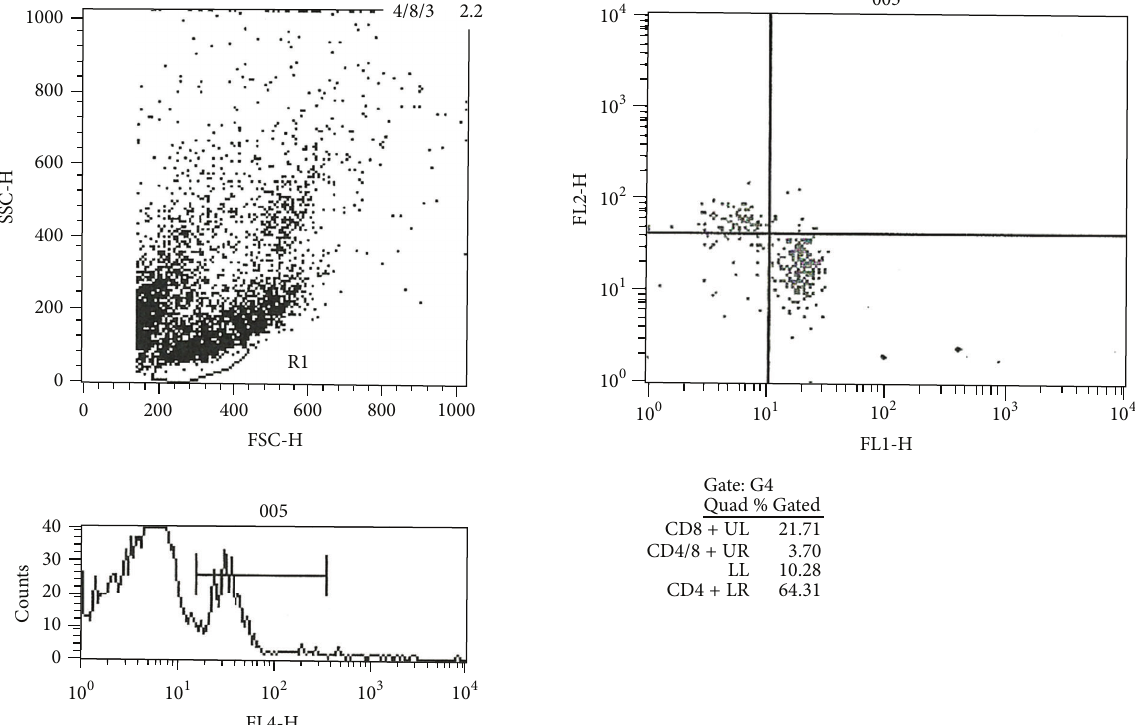
Figure 7: Example of one of the flow cytometry analyses where the percentages of each analyzed lymphocyte population (of a pup at postnatal day 15 belonging to the experimental transplantation group 3) are shown.